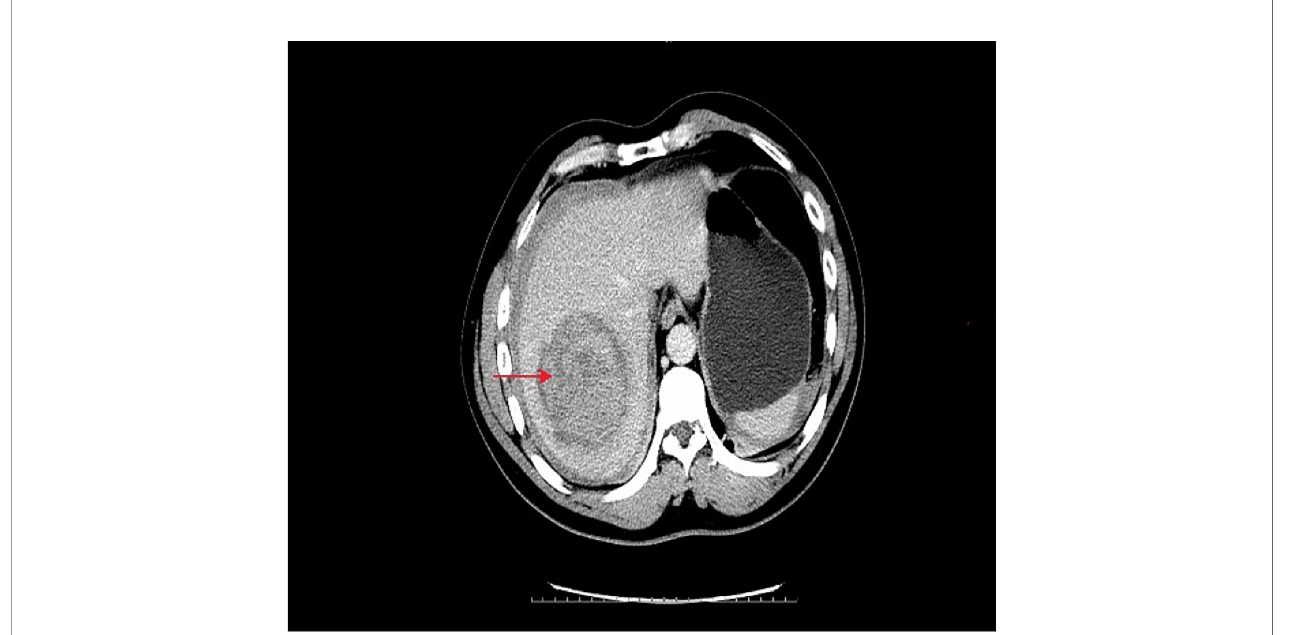
FIGURE 1 | Emergency CT of the abdomen showed a mixed density mass of about 8*8 cm in the right lobe of the liver. The lesion was near the right hepatic artery and free liquid density was visible around